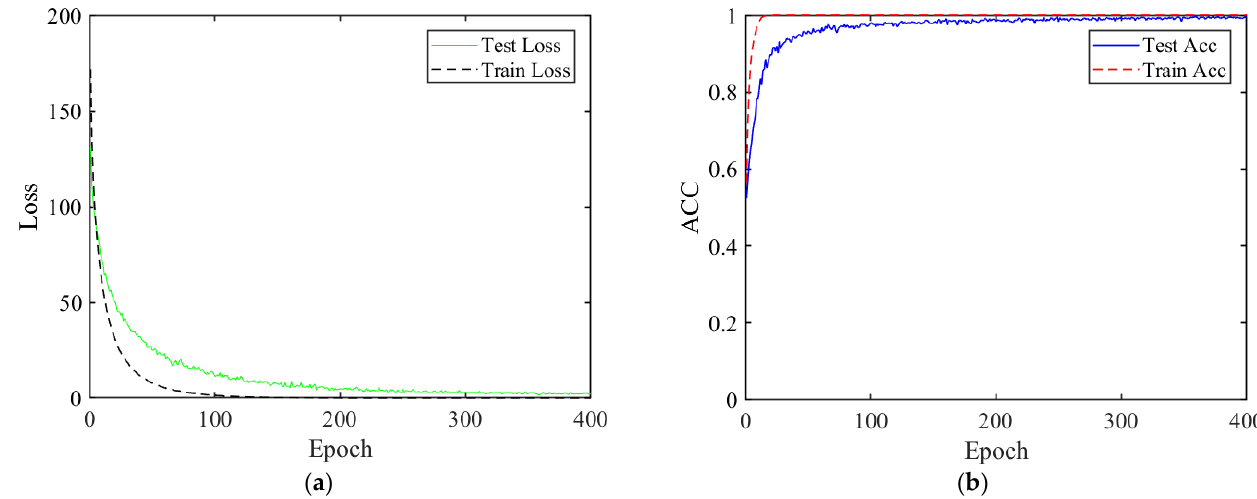
Figure 6. FEN learning ability. ( a ) Training–testing error curve; ( b ) Training–testing accuracy curve.